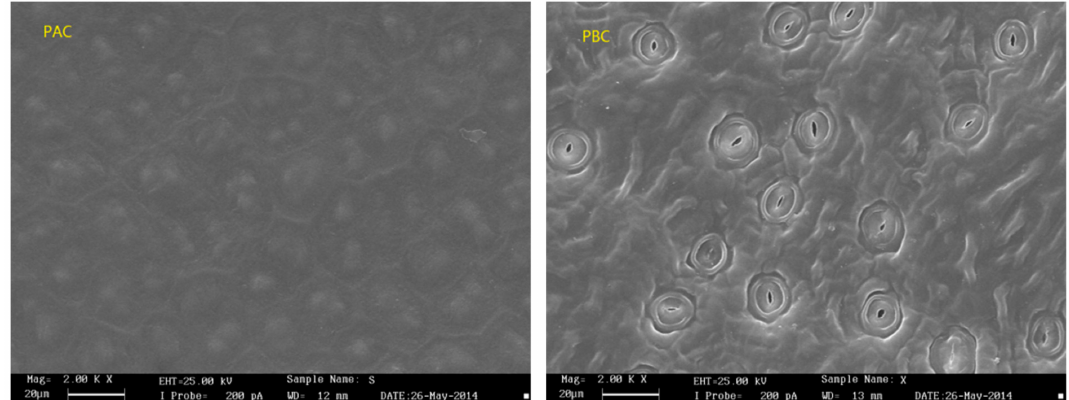
Figure 2. SEM micrographs of adaxial (PAC) and abaxial (PBC) cuticle of Photinia serrulata Leaf.